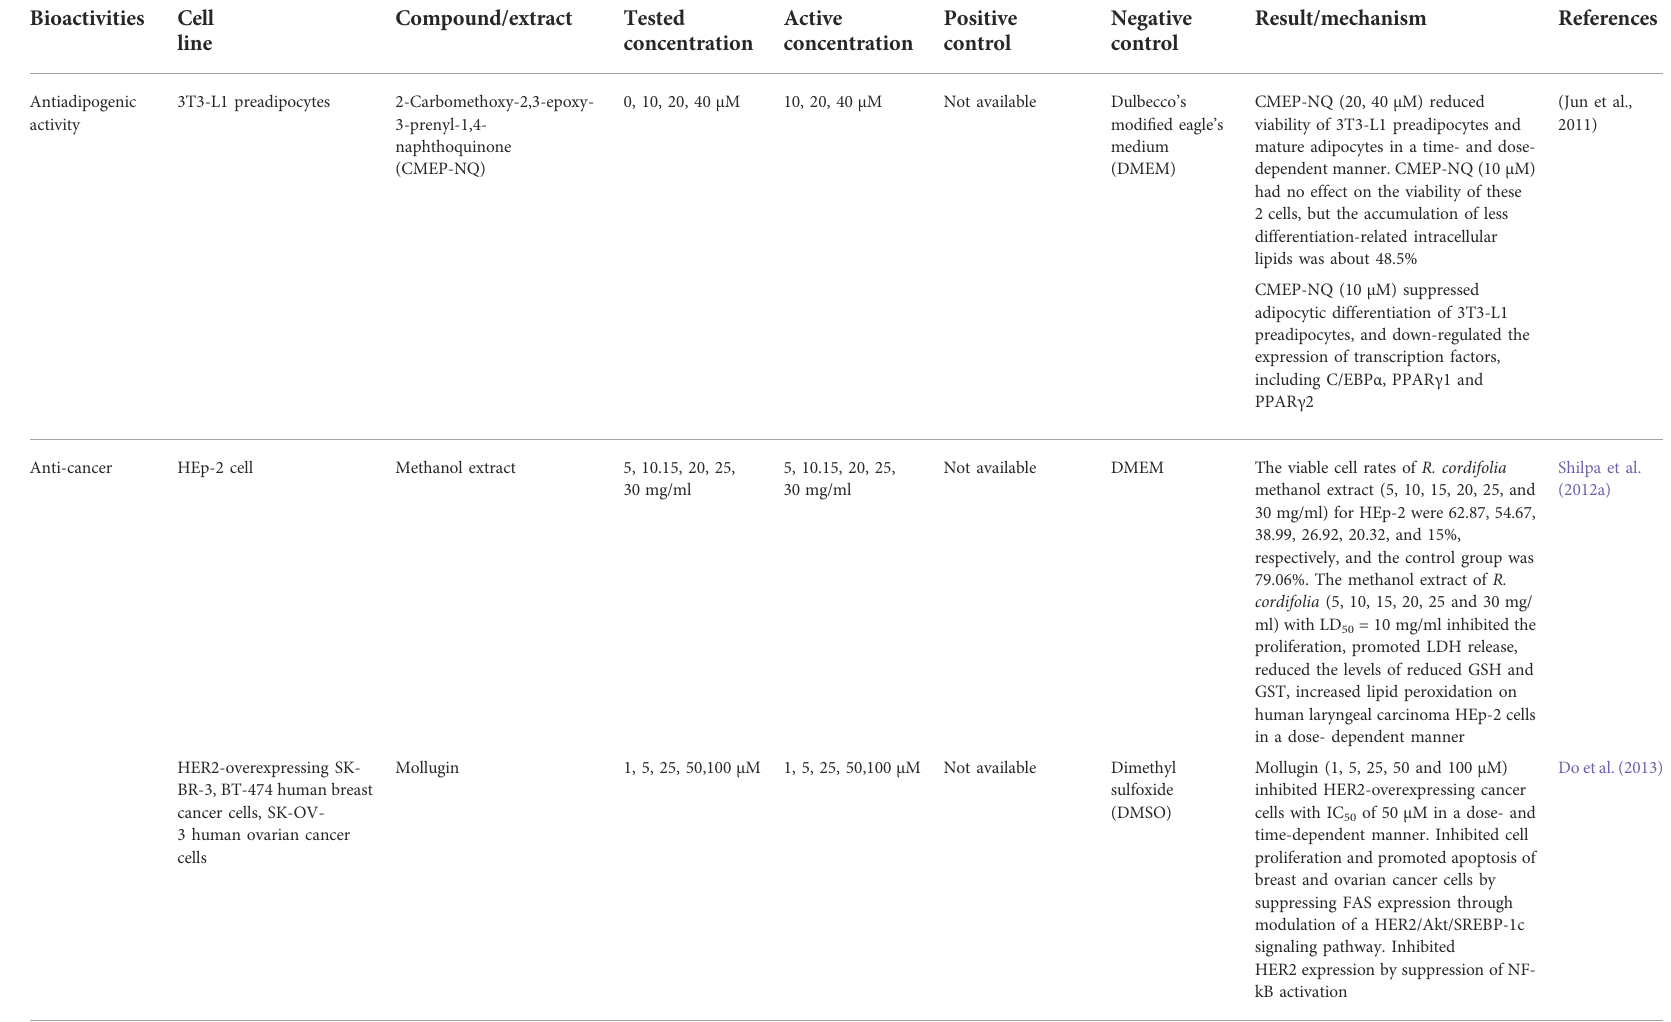
TABLE 2 In vitro study on the pharmacological effects of R.